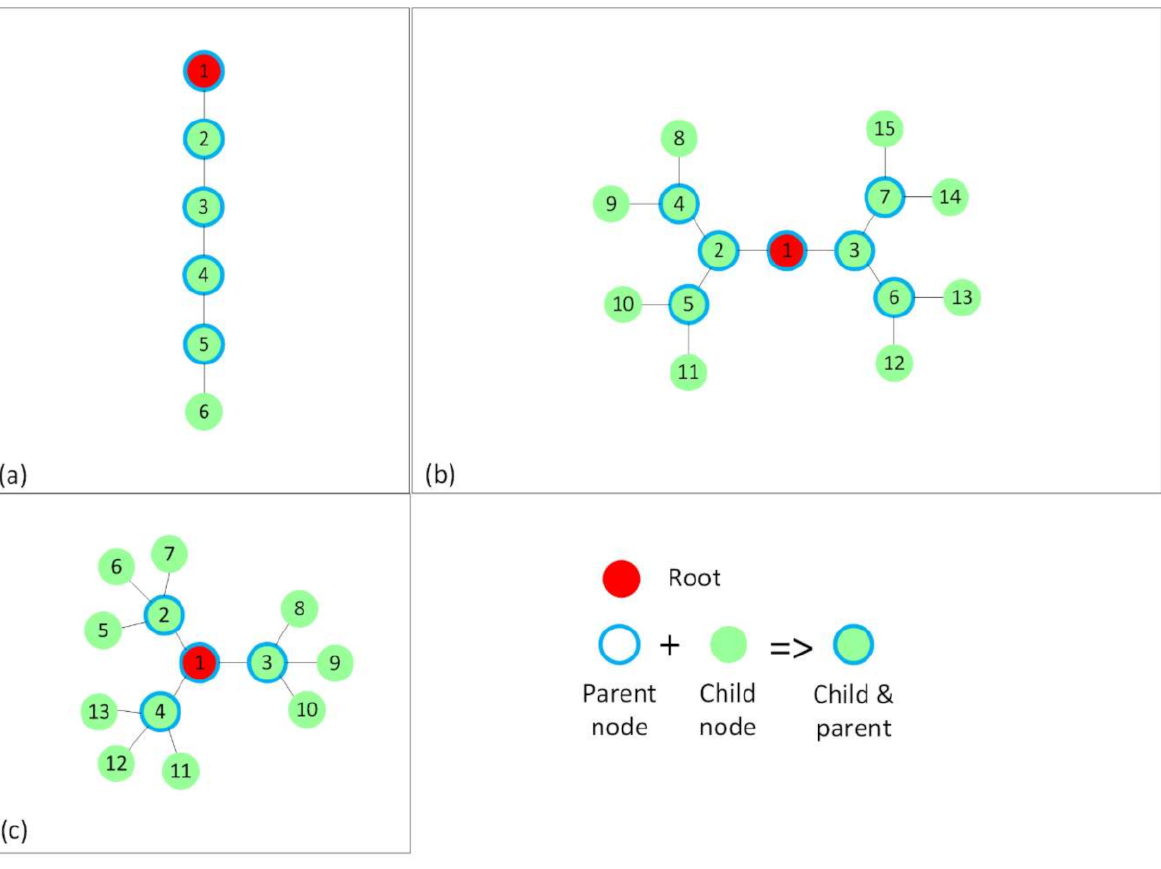
Figure 4. The RPL trees or topologies formed without interference between nodes of the same rank. ( a ) RPL tree showing a linear topology, in which each node, apart from the leaf node has one child. ( b ) RPL tree showing a topology in which each node, apart from the leaf nodes, has 2 children. ( c ) RPL tree showing a topology in which each node, apart from the leaf nodes, has 3